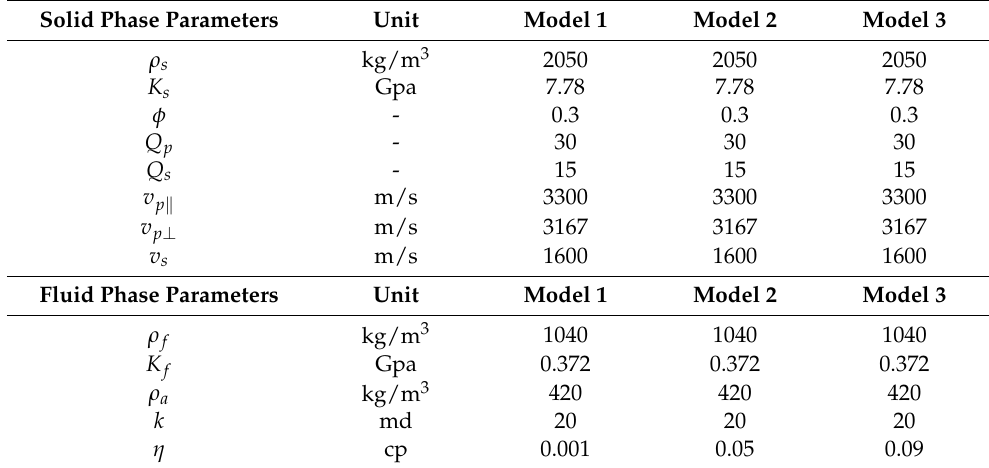
Table 1. Three models with different viscosity coefficients.